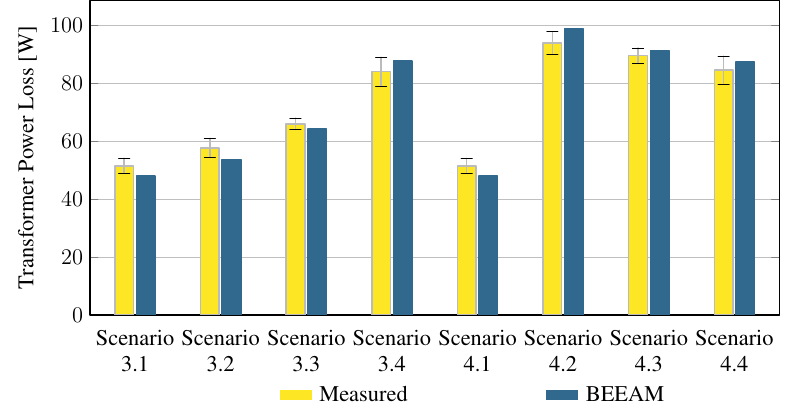
Figure A15. Predicted versus measured transformer loss, Scenarios 3 and 4.